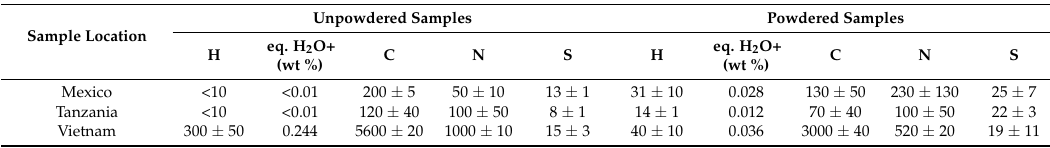
Table 4. Light volatile elements in unpowdered and powdered danburite samples provided as µ g · g − 1 ; calculated H 2 O+ values are given in wt